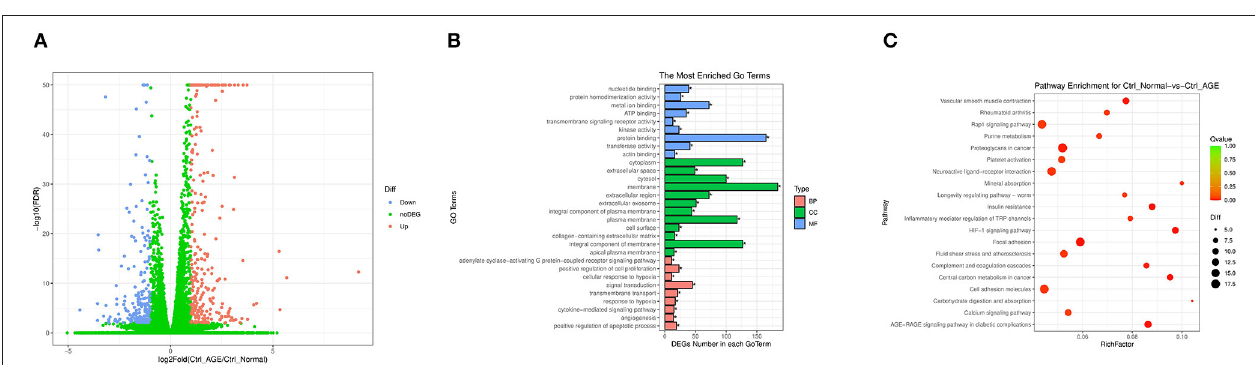
FIGURE 2 | AGEs accelerates the injury of HK-2 cells in a dose-dependent or time-dependent manner. (A) Flow cytometry analysis of apoptosis of HK-2 cells. (B,C) Reverse transcription-quantitative polymerase chain reaction (RT-qPCR) was used to detect the mRNA expression of 48, 72h fibrosis related factors TGF- β 1 and CTGF in HK-2 cells ( n = 3, ** p < 0.001). (D,E) Western blot was used to detect the protein expression of fibrosis and apoptosis related factors in HK-2 cells stimulated by 400 µ g/ml AGEs for 12, 24, 48, and 72h ( n = 3, * p < 0.05). (F) The morphological changes of HK-2 cells in Ctrl group and 400 µ g/ml AGEs stimulation group 72h later (scale bar, 100 µ m).